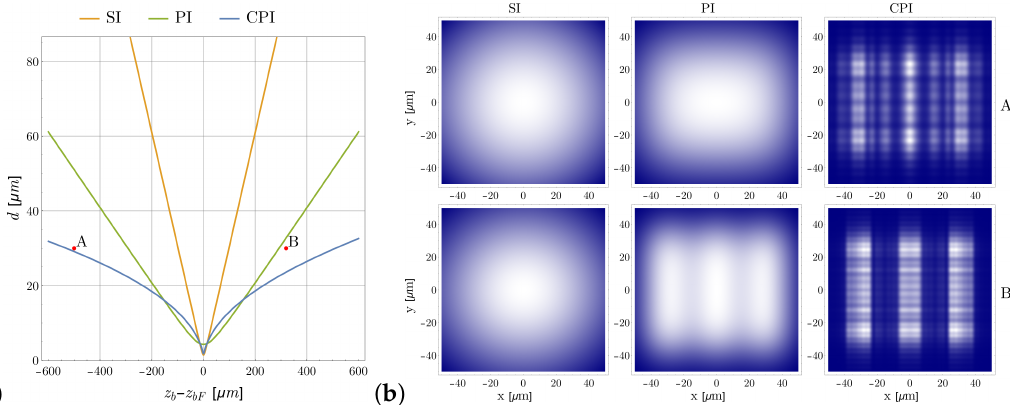
Figure 14. In ( a ), we plot the resolution of standard ghost imaging (SI), classical plenoptic imaging (PI) with 3 × 3 pixels for each microlens, and CPI with entangled photons, as a function of the longitudinal displacement z b − z bF of the sample from the focused object plane. In ( b ), we simulate the images of triple slit, placed in the points A (top row) and B (bottom row) in the case of SI, PI and CPI. Reproduced with the permission from [76], copyright 2018 Society of Photo Optical Instrumentation